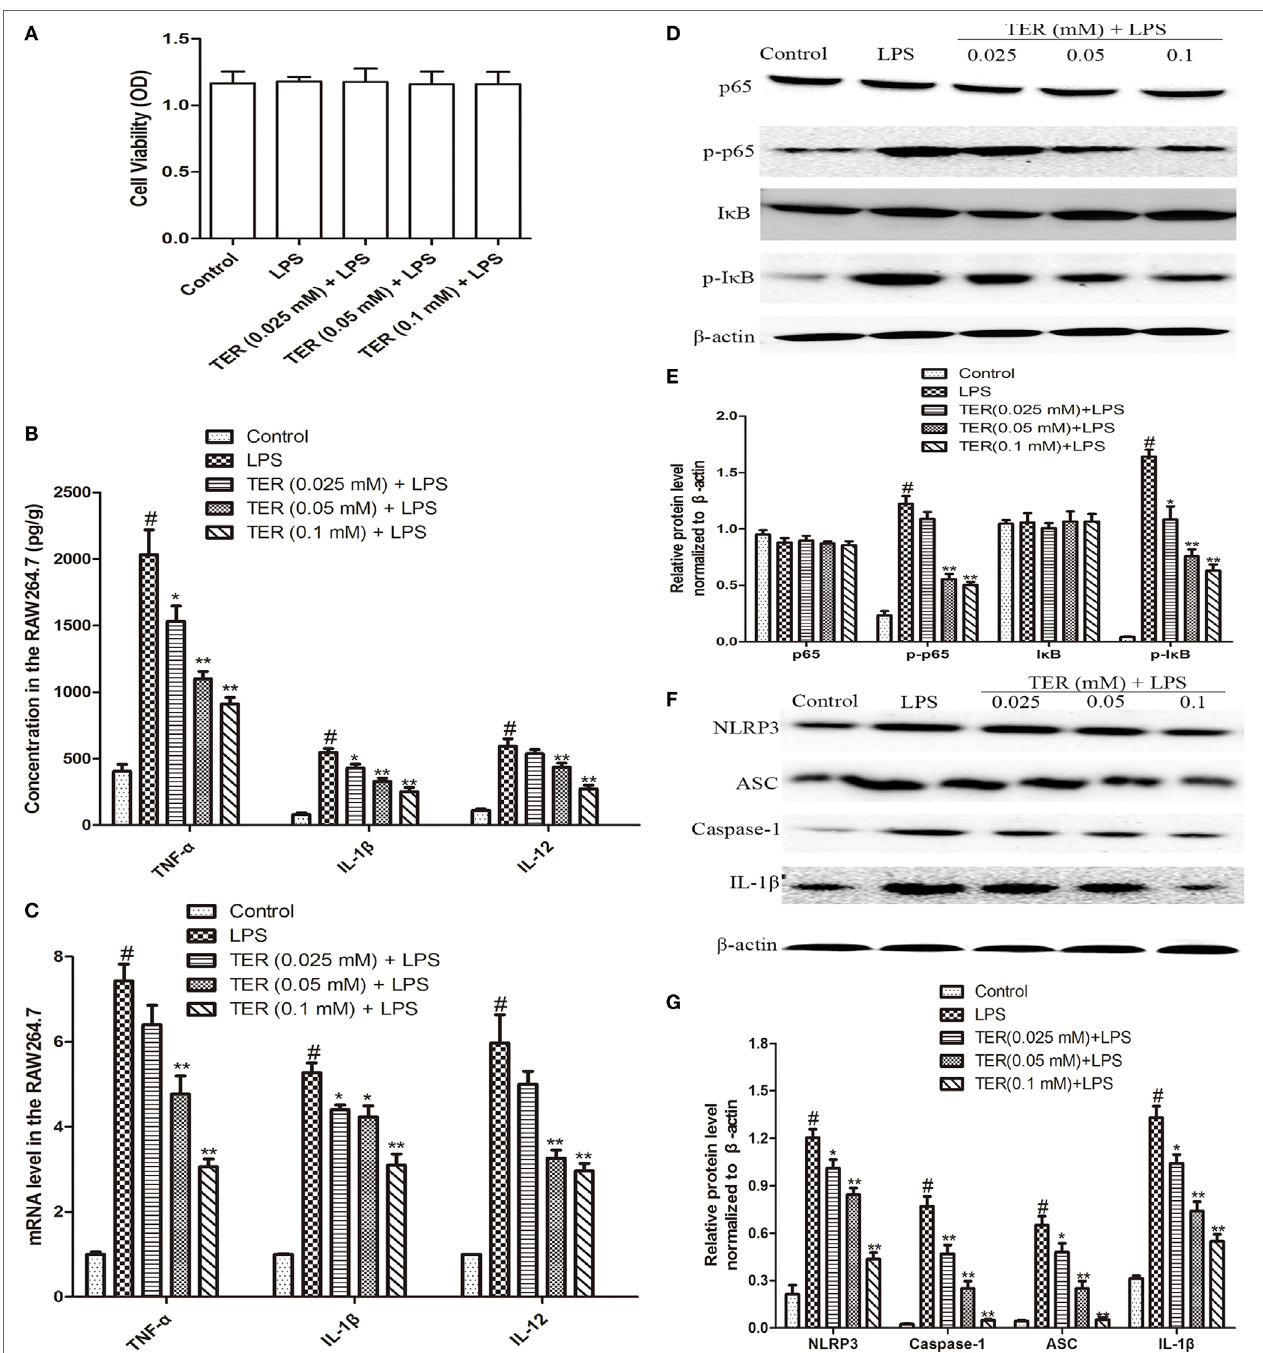
FigUre 3 | Terpinen-4-ol (Ter) decreases pro-inflammatory cytokines production and inhibits nF- κ B and nlrP3 inflammasome activation in lipopolysaccharide (lPs)-stimulated raW264.7 cells . Cells were treated with different concentrations of TER (0.025–0.1 mM) in the absence or presence of LPS (1 µg/mL). (a) Cell viability was determined using MTT assay. (B) Tumor necrosis factor α (TNF- α ), IL-1 β , and interleukin-12 (IL-12) levels were detected by enzyme-linked immunosorbent assay. (c) TNF- α , interleukin-1 β (IL-1 β ), and IL-12 mRNA levels were detected by quantitative real-time PCR. (D,F) Protein levels of NF- κ B p65, I κ B, NLRP3, ASC, caspase-1, and IL-1 β in LPS-stimulated RAW264.7 cells were analyzed by western blotting. (e,g) The relative protein expression of NF- κ B p65, I κ B, NLRP3, ASC, caspase-1, and IL-1 β were normalized to β -actin. The values presented are the means ± SD of three independent experiments. * p < 0.05 and ** p < 0.01 vs the group treated with only LPS; # p < 0.05 vs the control